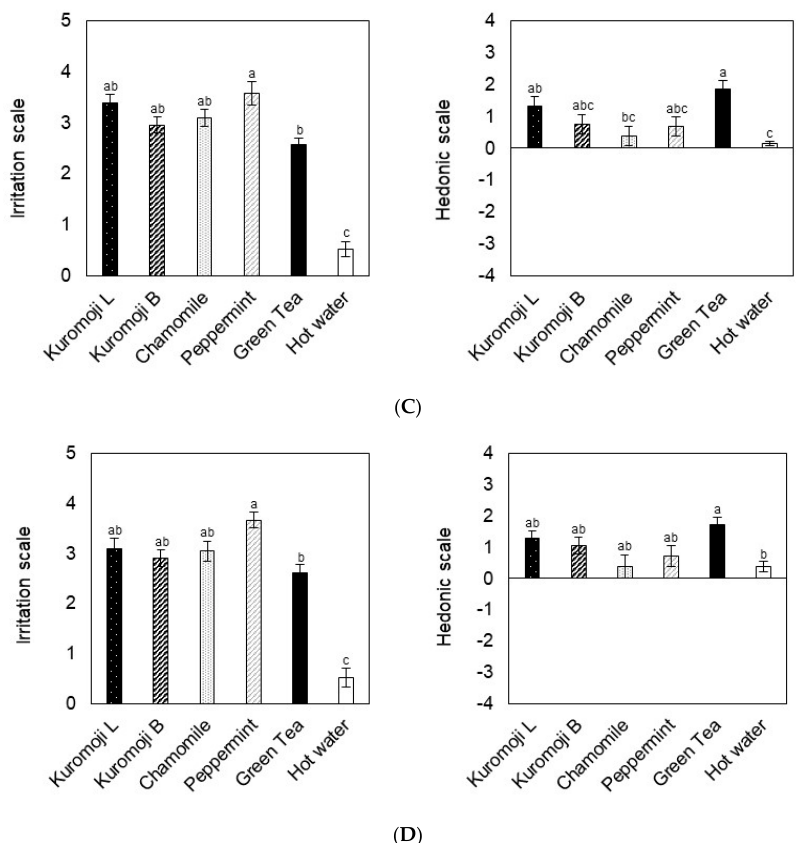
Figure 1. Subjective assessments of aroma for the experimental materials. Visual analog scale (VAS) scores in experiment 1 ( A ) and 2 ( B ) are shown. Irritation scores and hedonic scores in experiment 1 ( C ) and 2 ( D ) are also shown. Different letters represent statistically significant differences among experimental materials. Data are shown as means ± SEM.